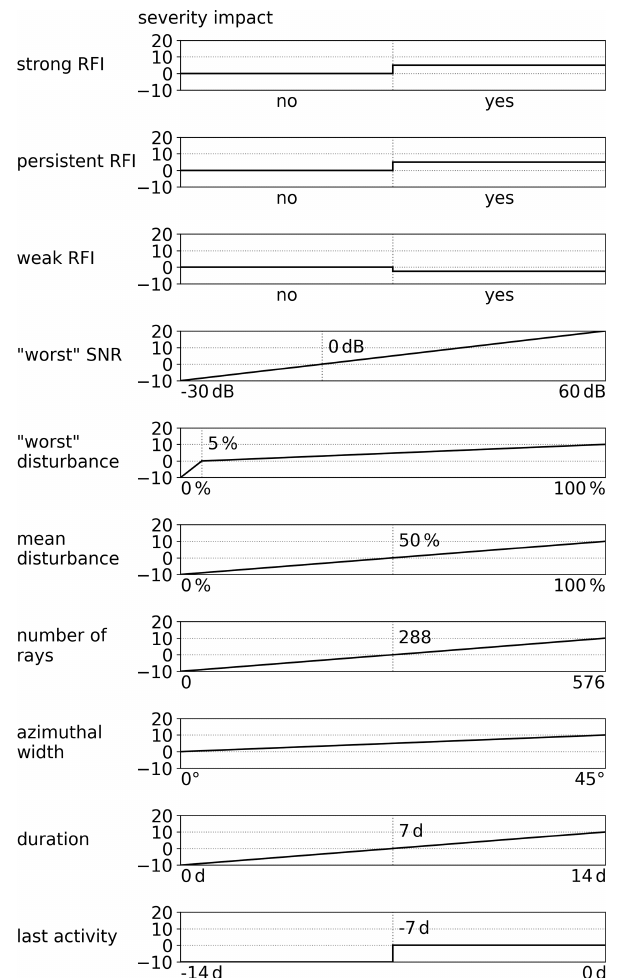
Figure 2. A panel for each of the factors used to determine the over- all RFI severity is shown. Each panel relates the underlying vari- able to a resulting severity impact. The top three panels relate to RFI classifications. All other panels relate to specific parameters of an individual RFI and contain minimum and maximum boundaries. Outside of the specified boundaries the last valid severity impact is